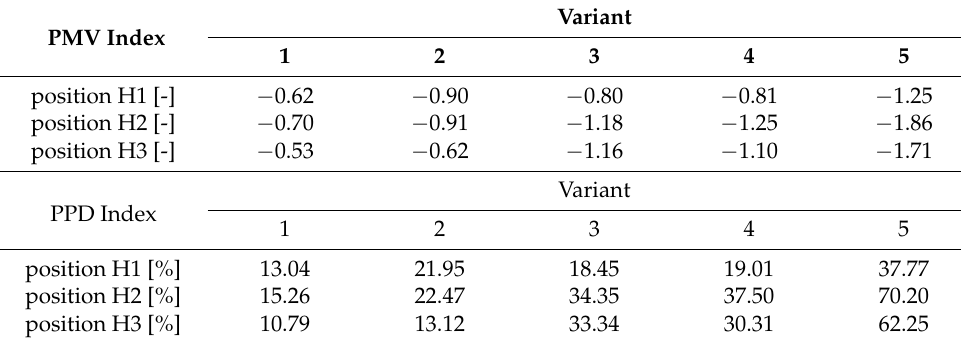
Table 5. PMV and PPD indexes for individual